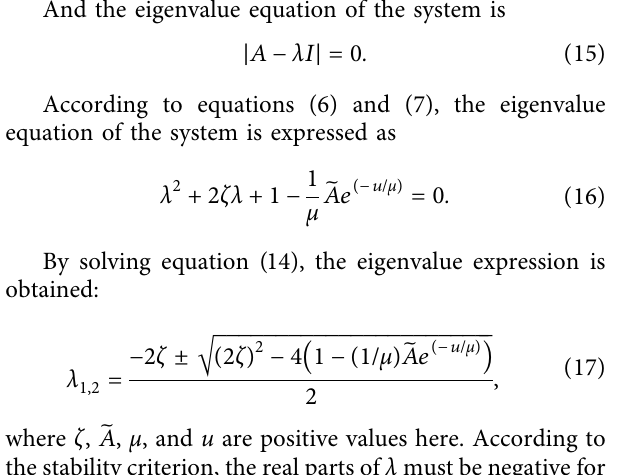
Figure 5: The influence of the preload amplitude 􏽥 A and the fitting parameter μ , on the 􏽥 K . (a) Different values of the parameter 􏽥 A . (b) Different values of the parameter